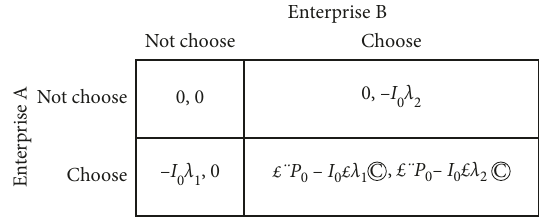
Figure 4: Static game return matrix of ecological enrichment.